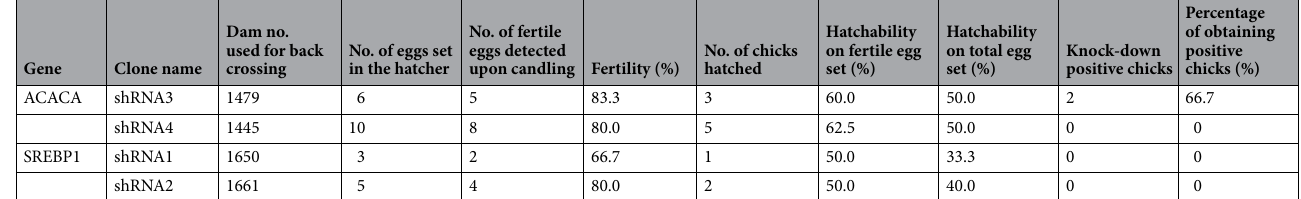
Table 11. Hatching performance of transgenic birds in 2nd generation. Female transgenic birds of first generation was back crossed with control broiler birds as male parents to produce back cross transgenic progenies carrying shRNA constructs. Two positive transgenic chicks were hatched only for ACACA shRNA group. The efficiency of production of transgenic chicks through backcross in ACACA group is very high